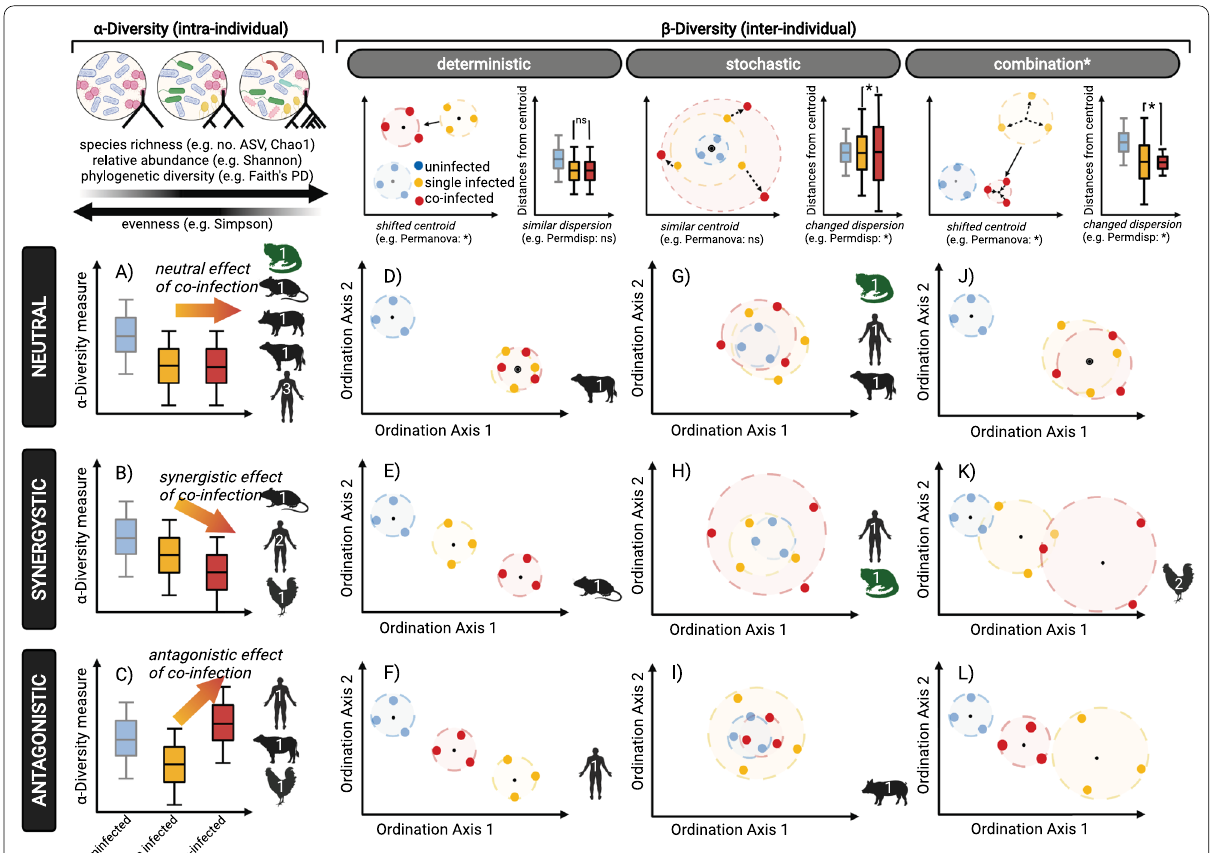
Fig. 2 A framework to assess the impact of co-infections on α- and ß-diversity of the host’s microbiome. The top banner provides an overview of different α-diversity metrics, and the patterns created by a shift in centroid (i.e., a deterministic effect with centroid black dot) or when plotted = as distance from centroid (i.e., a stochastic effect with spread black arrow), both describing ß-diversity. Based on the impact a single infection = (yellow) has on uninfected hosts (blue), the effect of a co-infection (red) can be classified as either neutral, synergistic or antagonistic. Animal symbols are in reference to the focal organism of studies featured in Table 1 and the number represents the frequency a similar result was found. * significant differences (i.e., p -value < 0.05); ns non-significant differences (i.e., p -value > = =